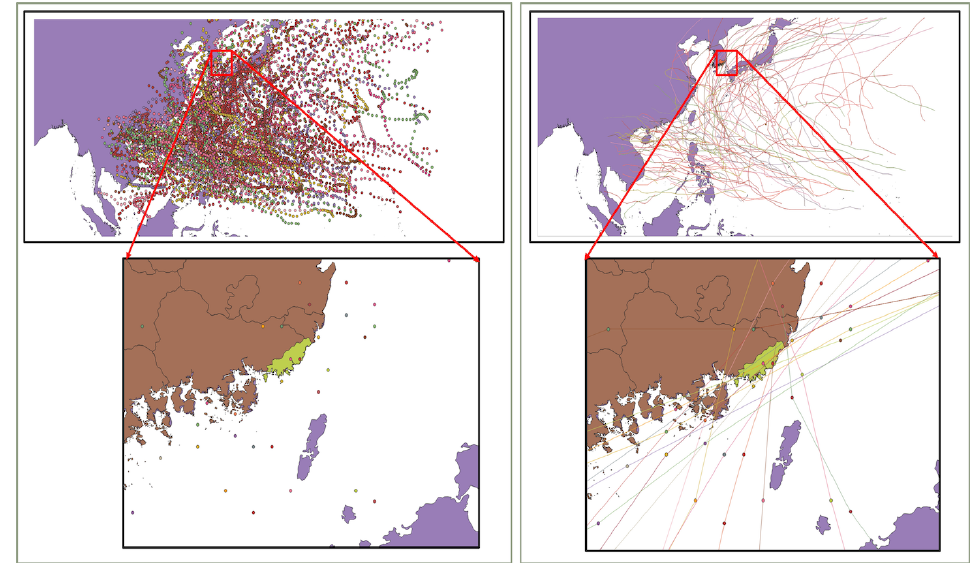
Figure 2. Conversion of typhoon tracks from points ( left ) to line vectors ( right ). Approximately 1600 typhoon tracks from 1951 ∼ 2020 over the western North Pacific Basin are